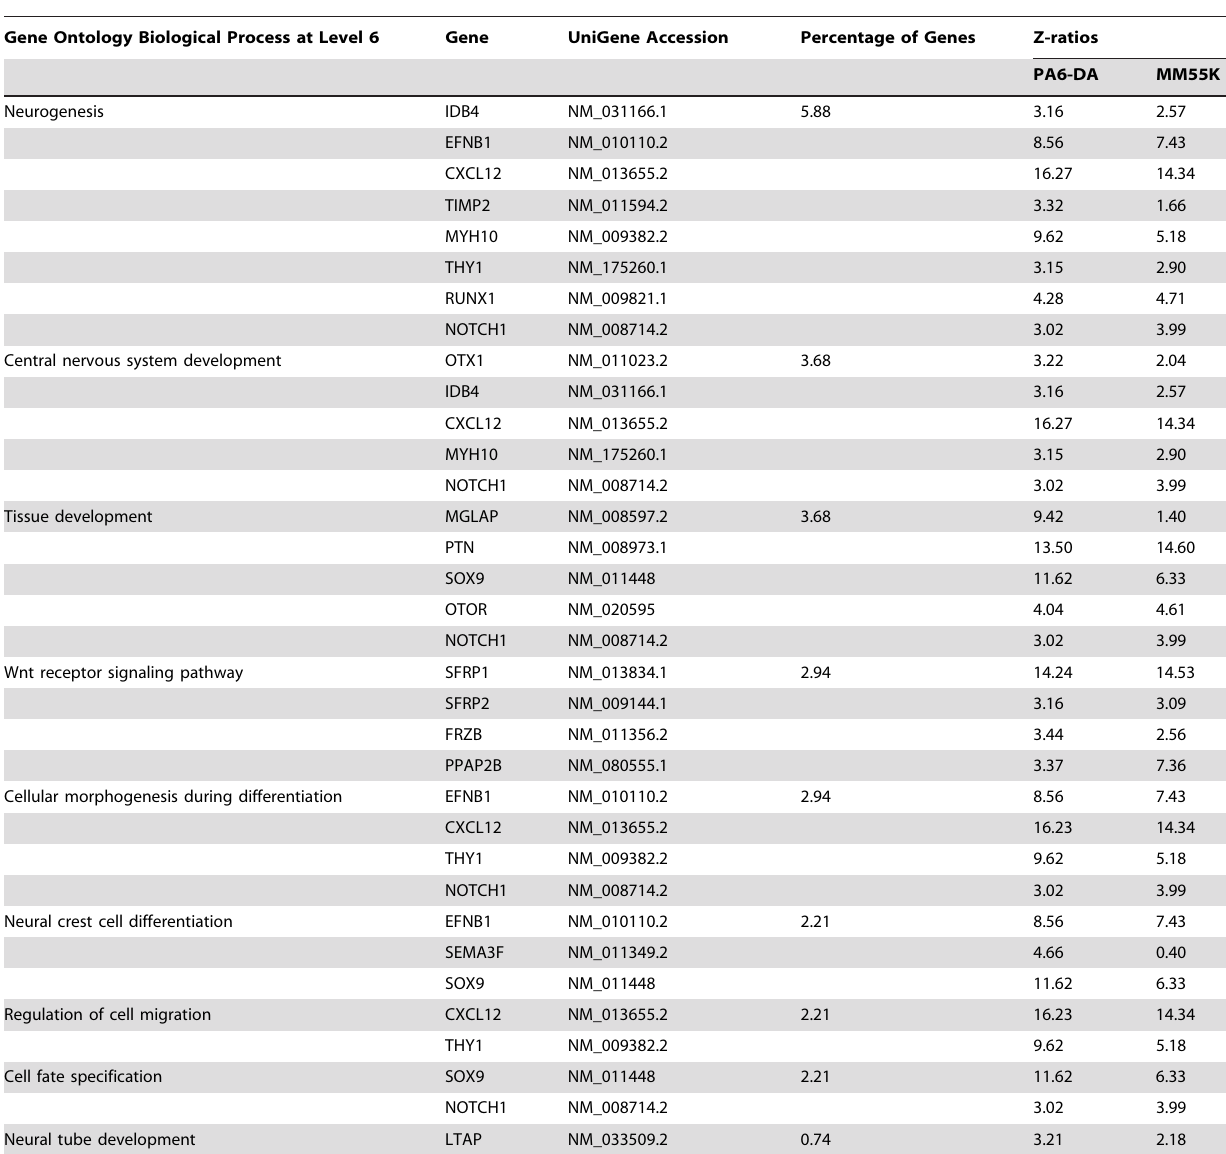
Table 1. Gene clusters highly expressed in PA6-DA